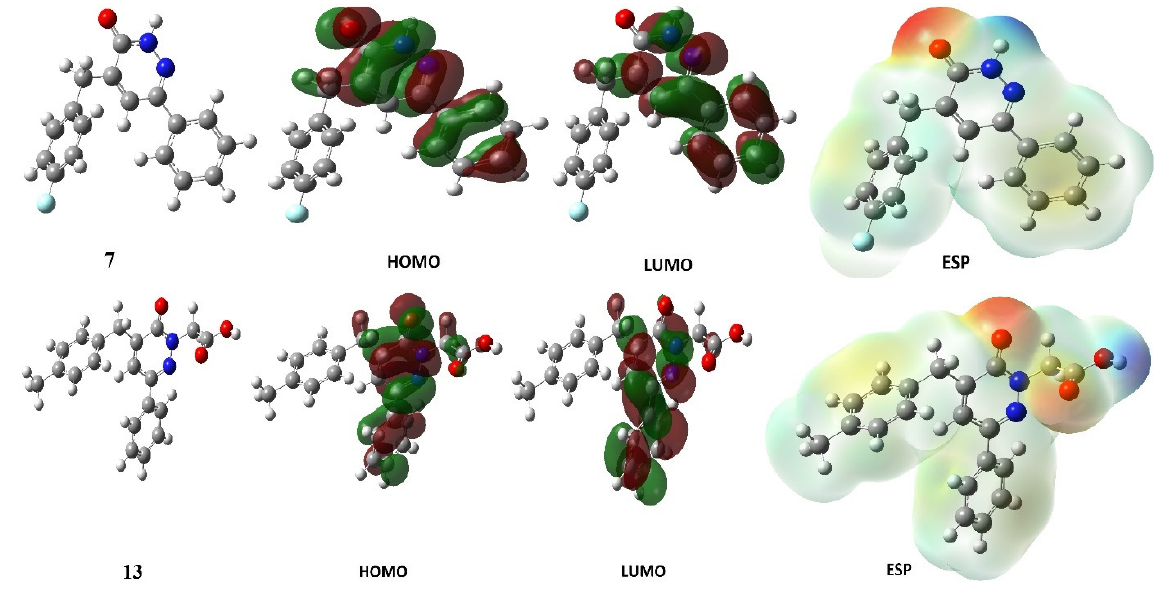
Figure 3. Shapes of optimized structure, HOMO, LUMO, and ESP of compounds 7 and 13 obtained by B3LYP/6-31++G(d,p) level. Table 3. Quantum chemical descriptors based upon DFT calculations for compounds 7 and 13 .